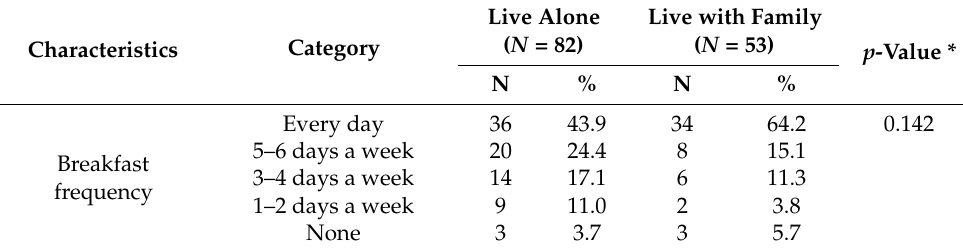
Table 2. Lifestyle characteristics depending on living status.